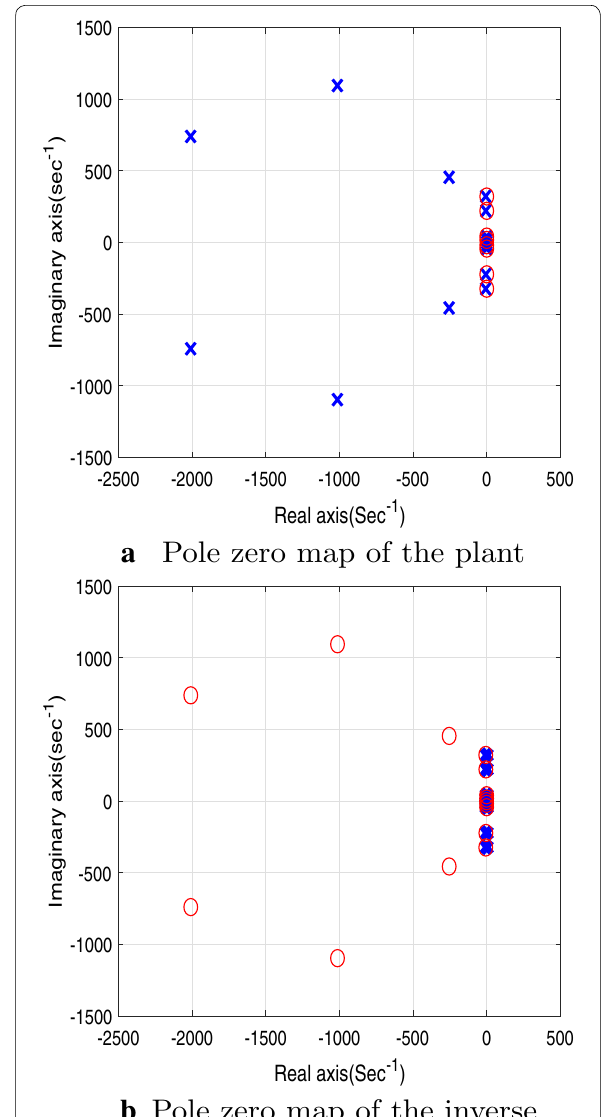
Fig. 5 Poles and zeros of the plant and its inverse. a The distribution of the poles and the zeros of the modelled and linearized manipulator. b The distribution of the poles and the zeros of the inverted